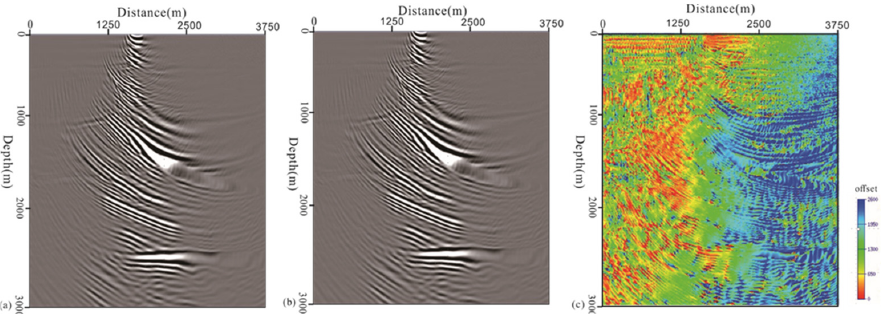
Figure 2 . ( a ) Results from the migration of the original single shots; ( b ) results from the migration the of modulated single shots; ( c ) attributes of the surface offsets obtained from ratios of ( a,b ).